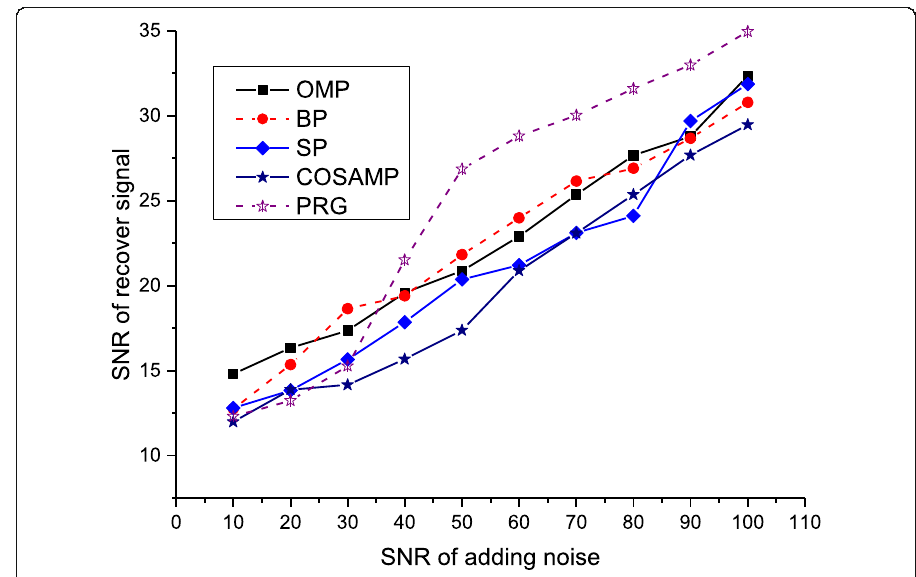
Fig. 6 Sensor signal reconstruction under sinusoidal signal plus narrowband Gaussian noise. The SNR of the reconstructed wireless sensor signal by PRG, OMP, SP, BP, and COSAMP. The SNR of noise is 10, 20, 30, 40, 50, 60, 70, 80, 90, and 100, respectively